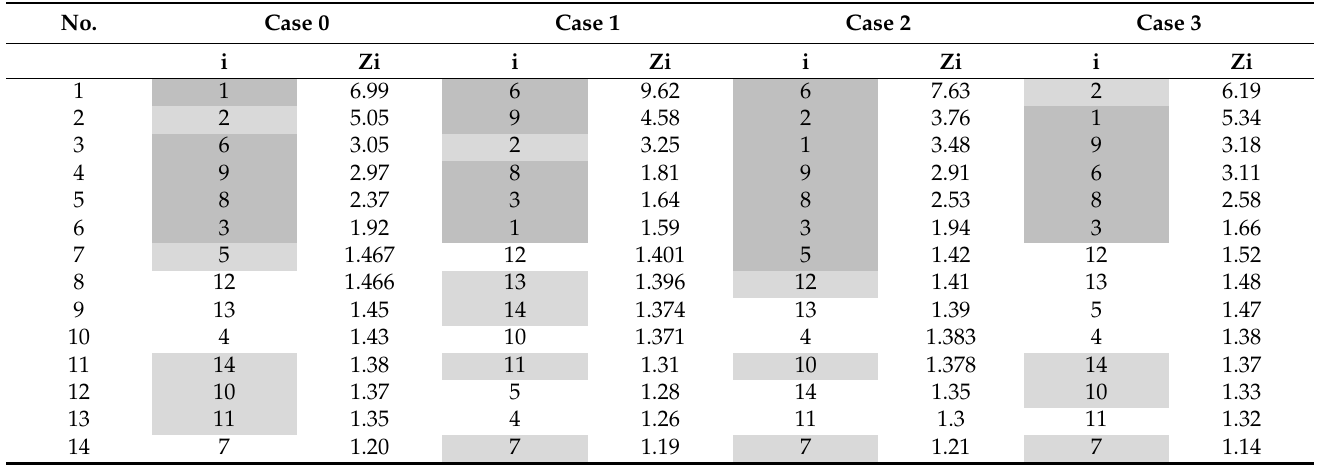
Table 22. The ranking list of the TS nodes, when a ranking criterion is the index Z, for considered study